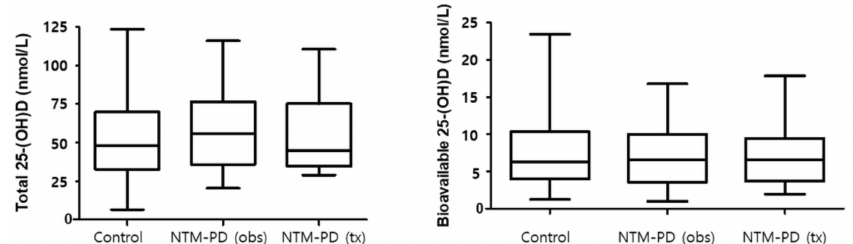
Figure 5. Total and genotype-specific bioavailable 25-(OH)D of patients with nontuberculous mycobacterial (NTM) pulmonary disease and healthy controls. NTM-PD, nontuberculous mycobacterial pulmonary disease; obs, observation group; tx, treatment group; Box plot shows median (central line), 25% and 75% quartile ranges.